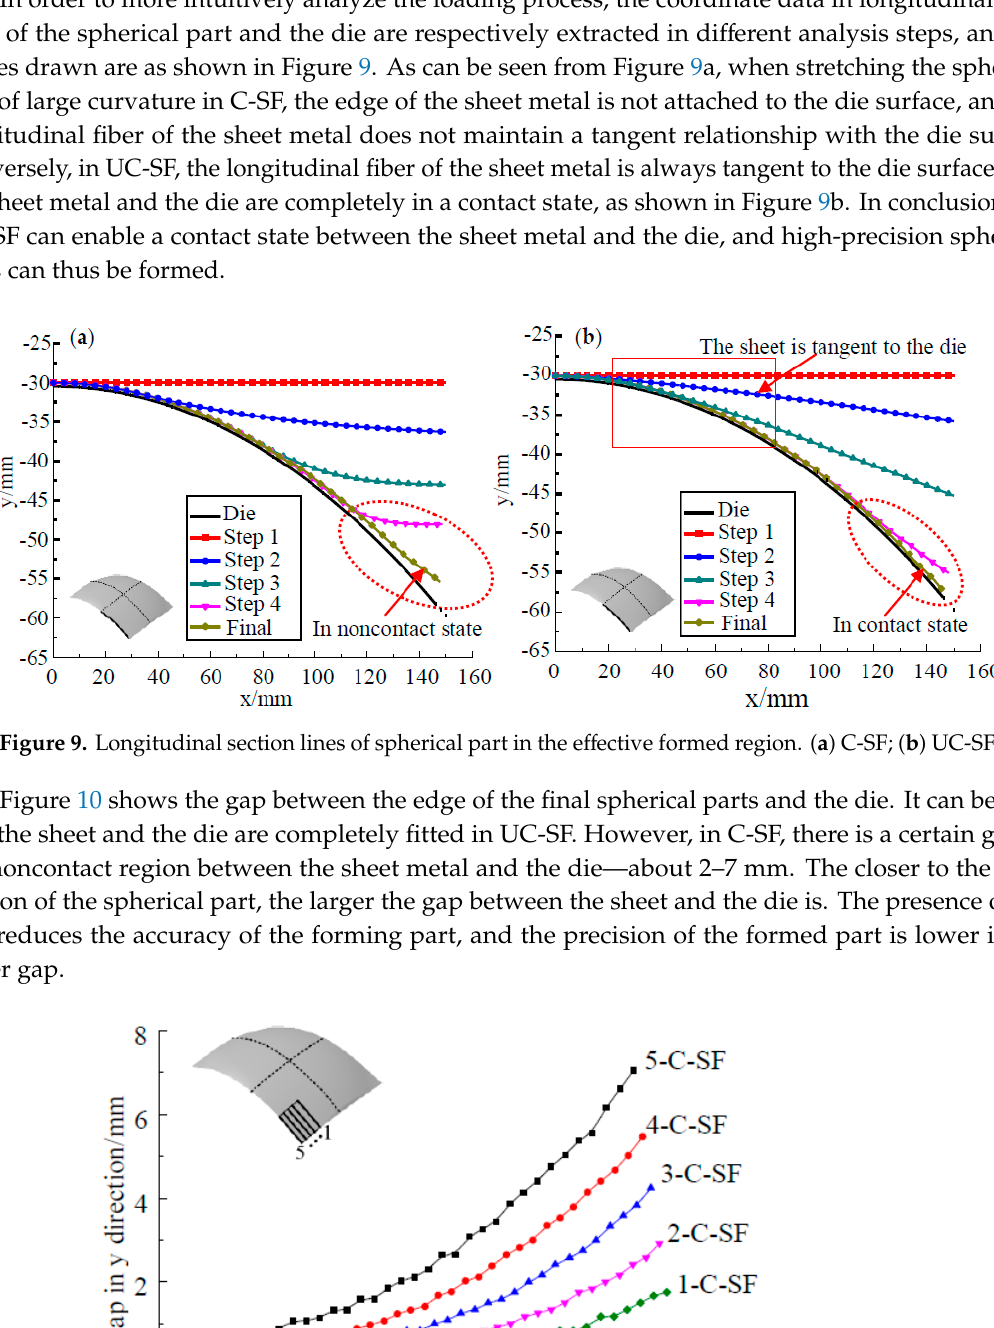
Figure 8. Contact state for spherical part. ( a ) Contact state evolution; ( b ) final contact state.